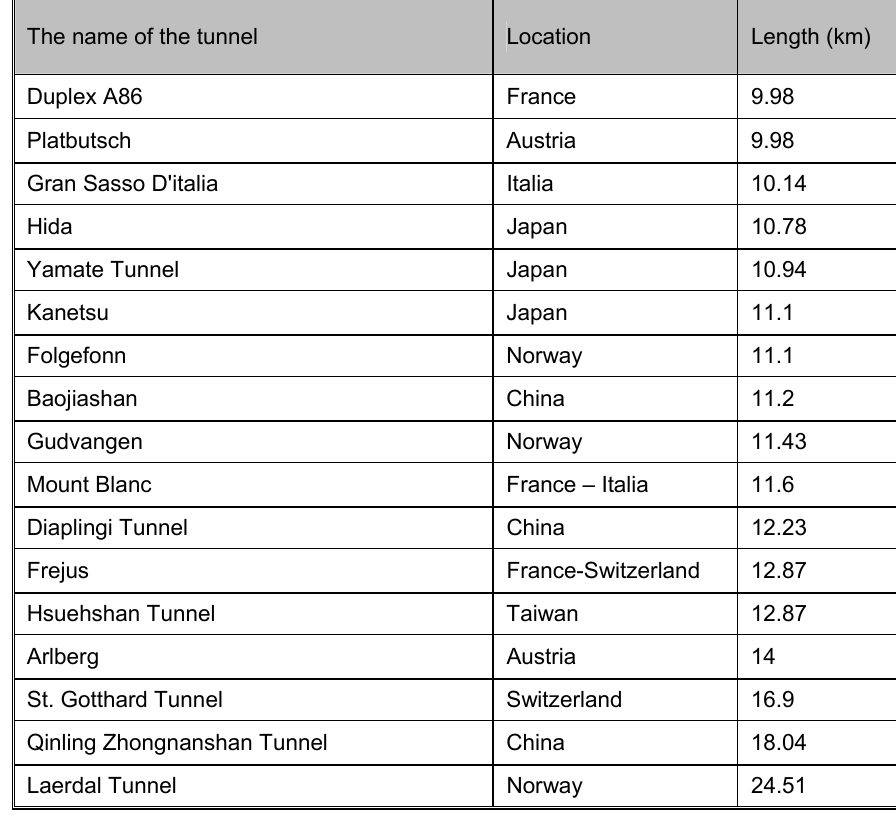
Table 1 – The longest road traffic tunnels in the world (Automagazin, 2011) Таблица 1 – Самые длинные автодорожные тоннели мира (Automagazin,